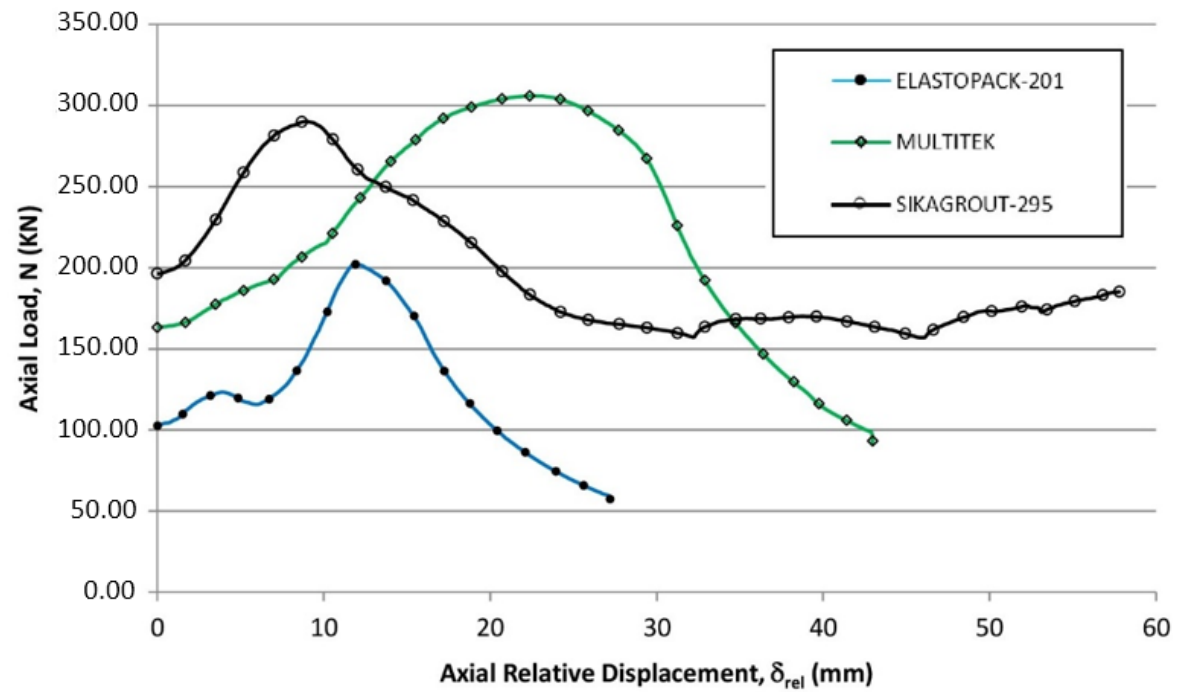
Figure 7. Load versus relative displacement curves of the tested elements from the second load cycle (abscissa: “N 1,min ” values of each of the tubes have been synchronized at the origin— δ rel ). The unloading points are matched at the origin and the displacements are the increases over the departure time.